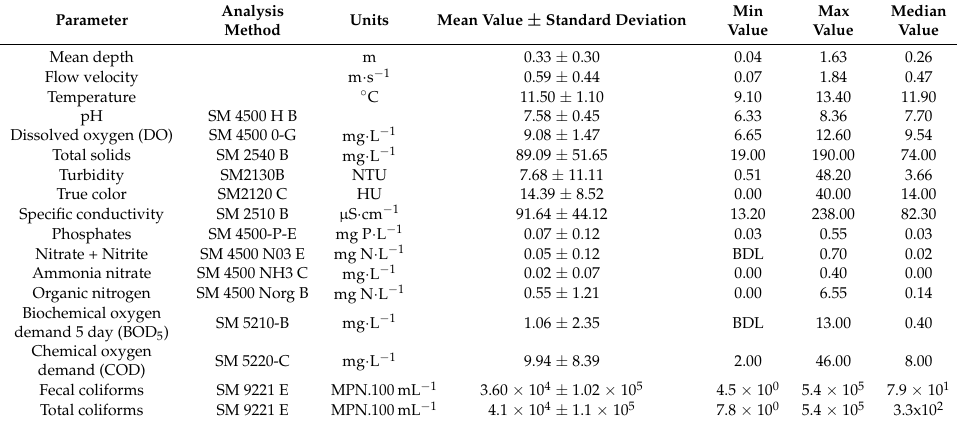
Table A1. Summary of the physical, chemical and microbiological data collected in the Machangara basin in Ecuador based on 33 samples during February and March of 2012.